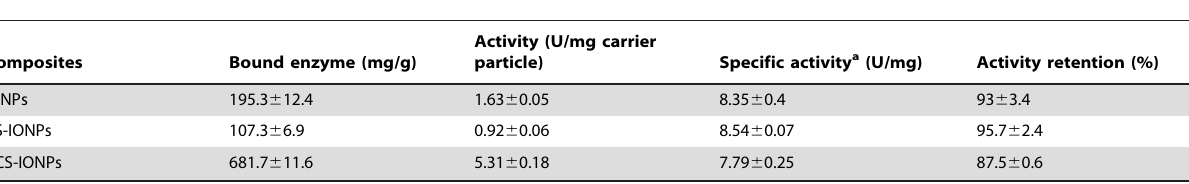
Table 1. The immobilization efficiency of the composites and the specific activity of the immobilized enzyme.